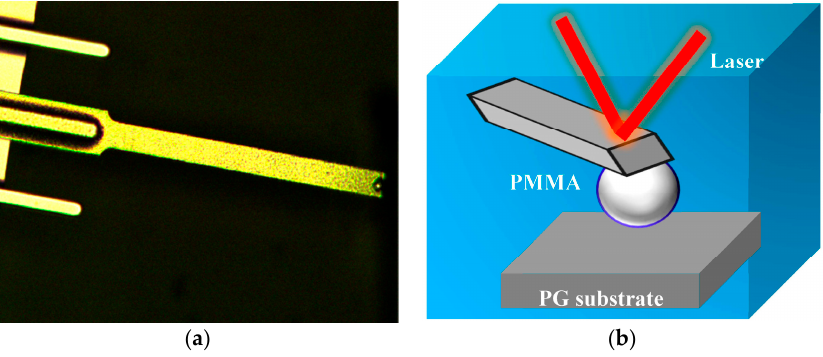
Figure 3. PMMA colloid probe ( a ) and the schematic of force measurement ( b ). The width of cantilever is 34 μ m.